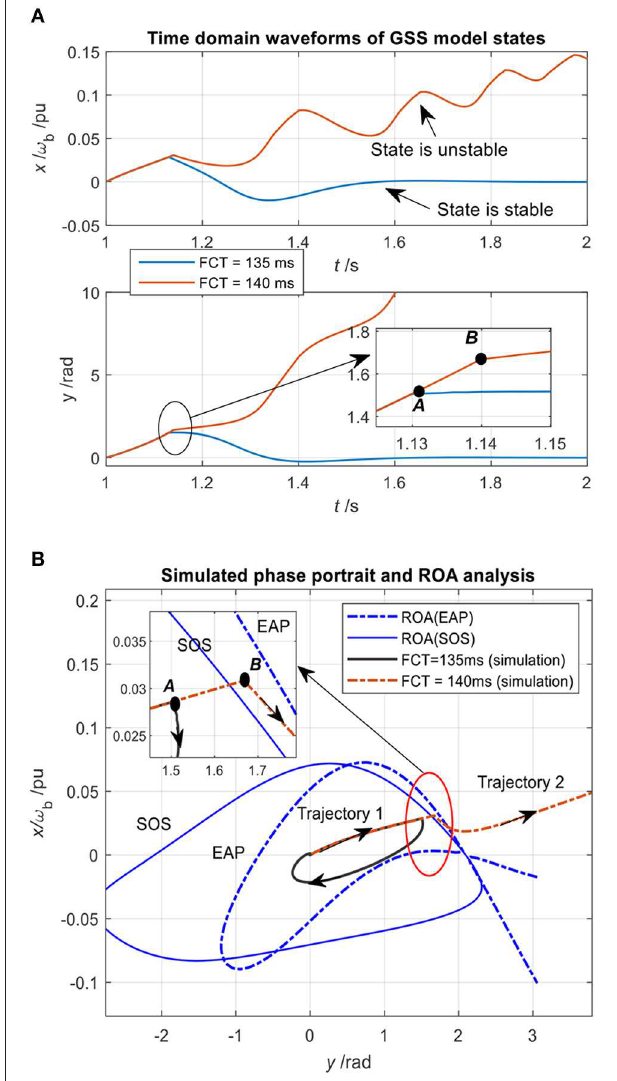
FIGURE 7 | (A) Time-domain waveforms of states relevant to GSS model. (B) State trajectories in comparison with ROA